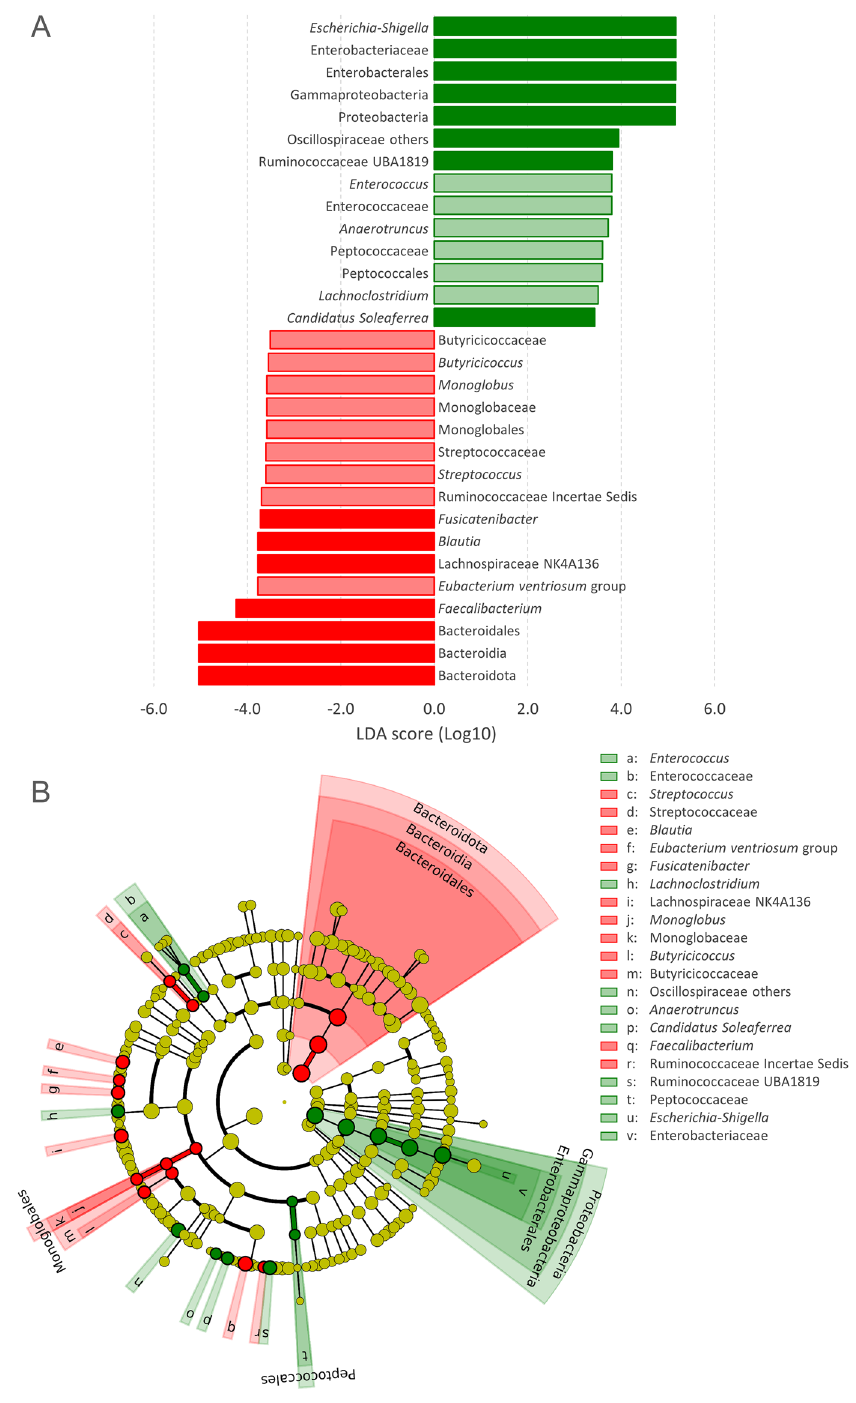
Figure 3. Effect of mucin enrichment on faecal microbiota. The taxonomic biomarkers characterizing FS and EC according to LEfSe are colored in red and green, respectively. ( A ) Logarithmic LDA scores of the taxa exhibiting significant differential abundance (P < 0.05, logarithmic LDA score ≥ 2.0) between FS and EC; taxa that were > 1% in at least one sample are reported with bars in dark shades. ( B ) Cladogram visualization of the taxonomic biomarkers. The figure was created with the software LEfSe, Galaxy version 1.0, available at https:// hutte nhower. sph. harva rd. edu/